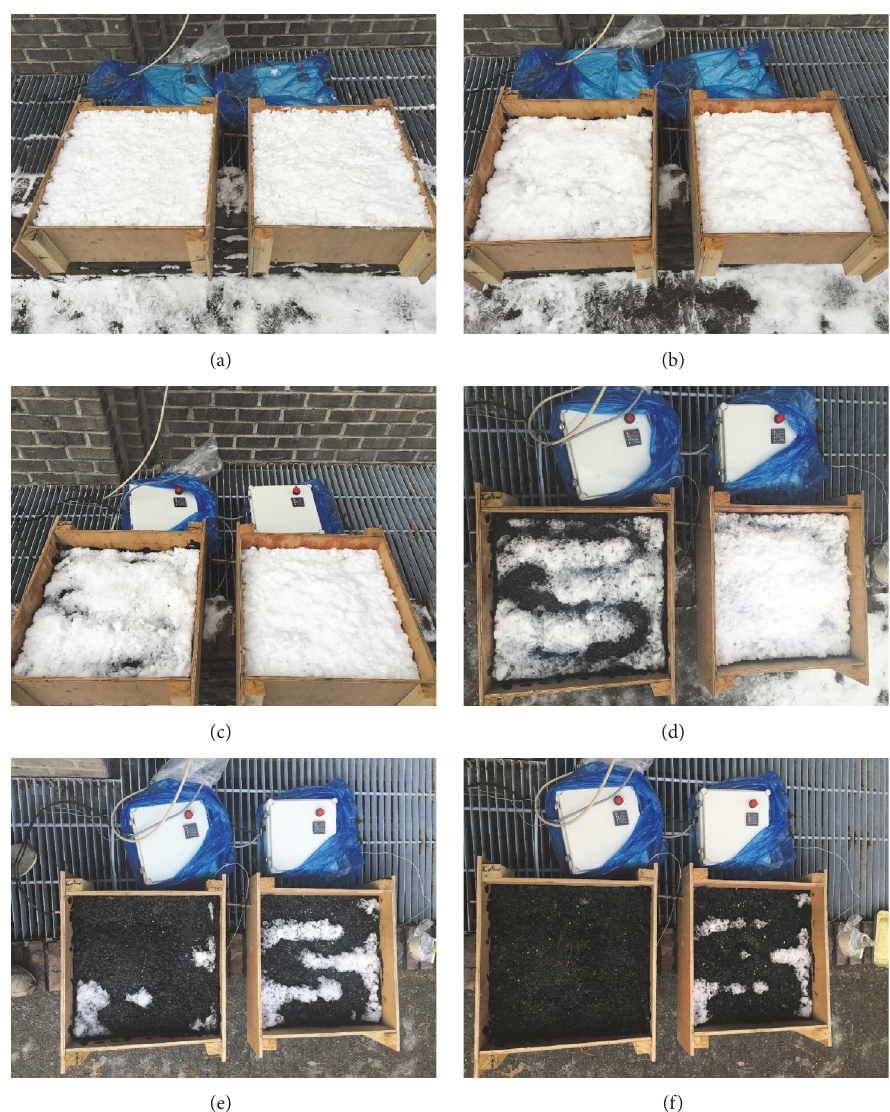
Figure 7: Actual test results: (a) at beginning, (b) 5 minutes, (c) 10 minutes, (d) 15 minutes, (e) 20 minutes, and (f) 25